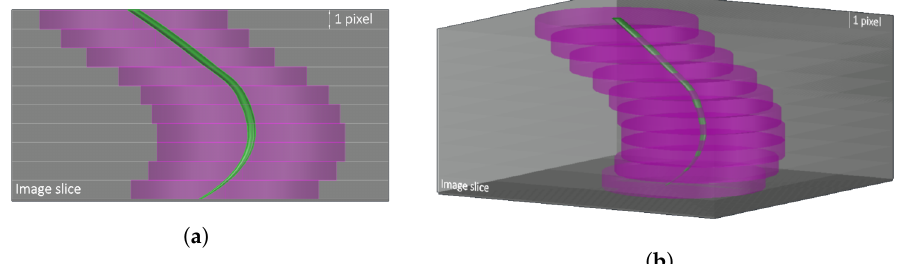
Figure 4. Schematic of laminar cylinder around root used as region of interest (ROI) to calculate parameters of geotechnical interest for varying elevation: ( a ) side view ( b ) perspective